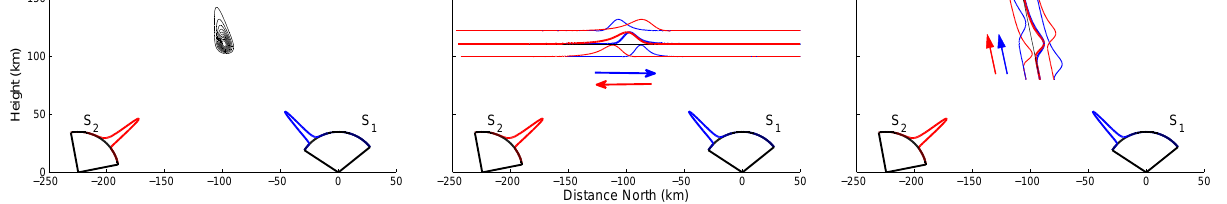
Fig. 1. Cartoon showing the projection of images of an auroral arc located between two stations (shown in left panel) onto three different horizontal planes (middle panel) and three different geomagnetic field lines (right panel). The colour-coded arrows in the middle and right panels indicate the “up” direction in each projection. This shows that in the case of the horizontal plane the shape of the two projections is flipped.